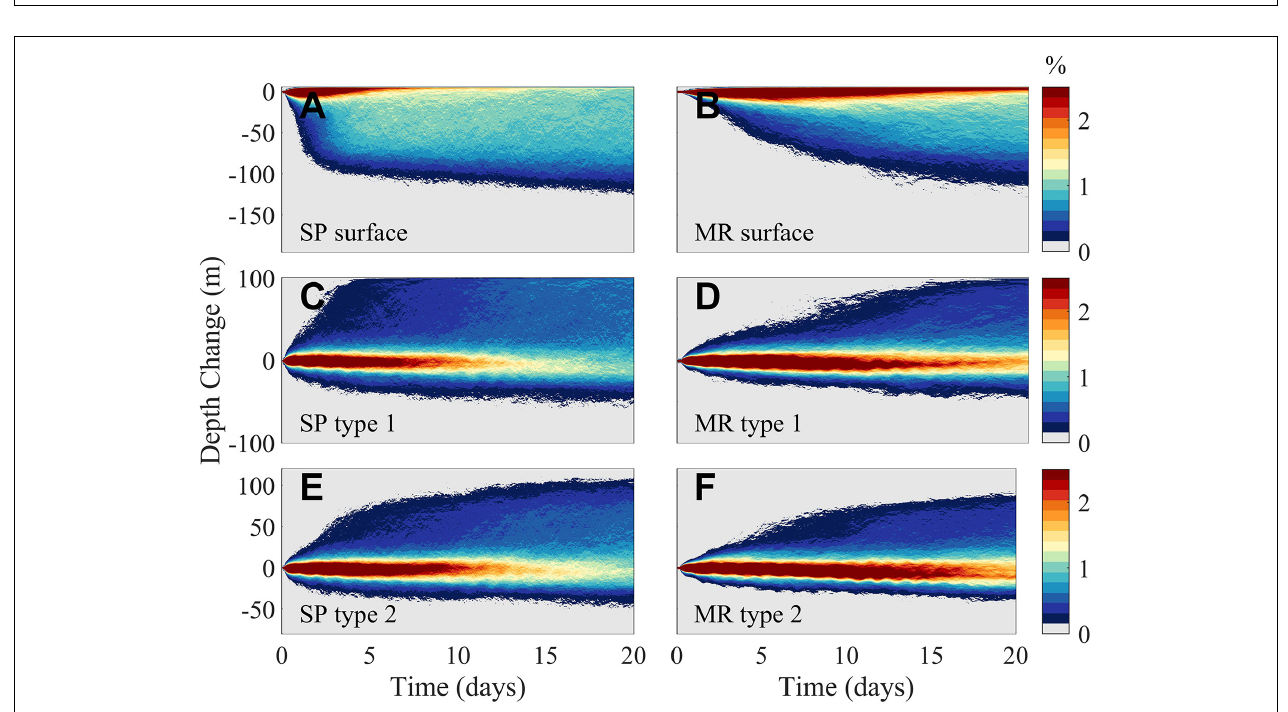
FIGURE 8 | Time evolution of the depth variation of particles in the first winter release (release date: January 25, 2015) expressed as percentage. The particles are released at a depth of 5 m (A,B) , 100 m (C,D) and 20 m below the local mixed layer (E,F) . SP run on left and MR run on the right.